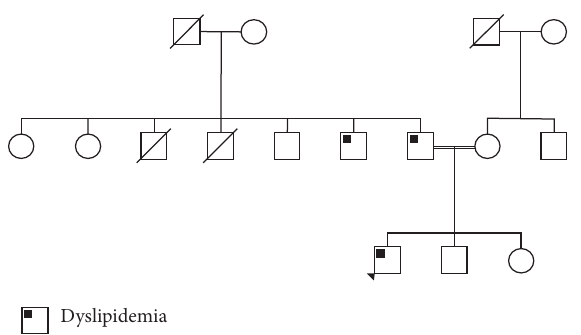
Figure 1: Te patient’s family